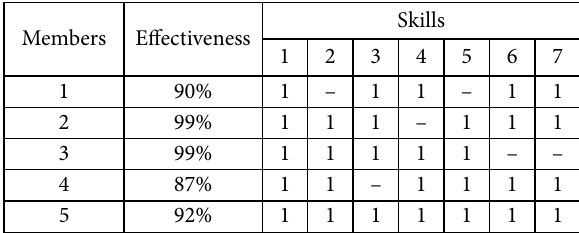
Table 7. The matrix of members’ effectiveness and skills